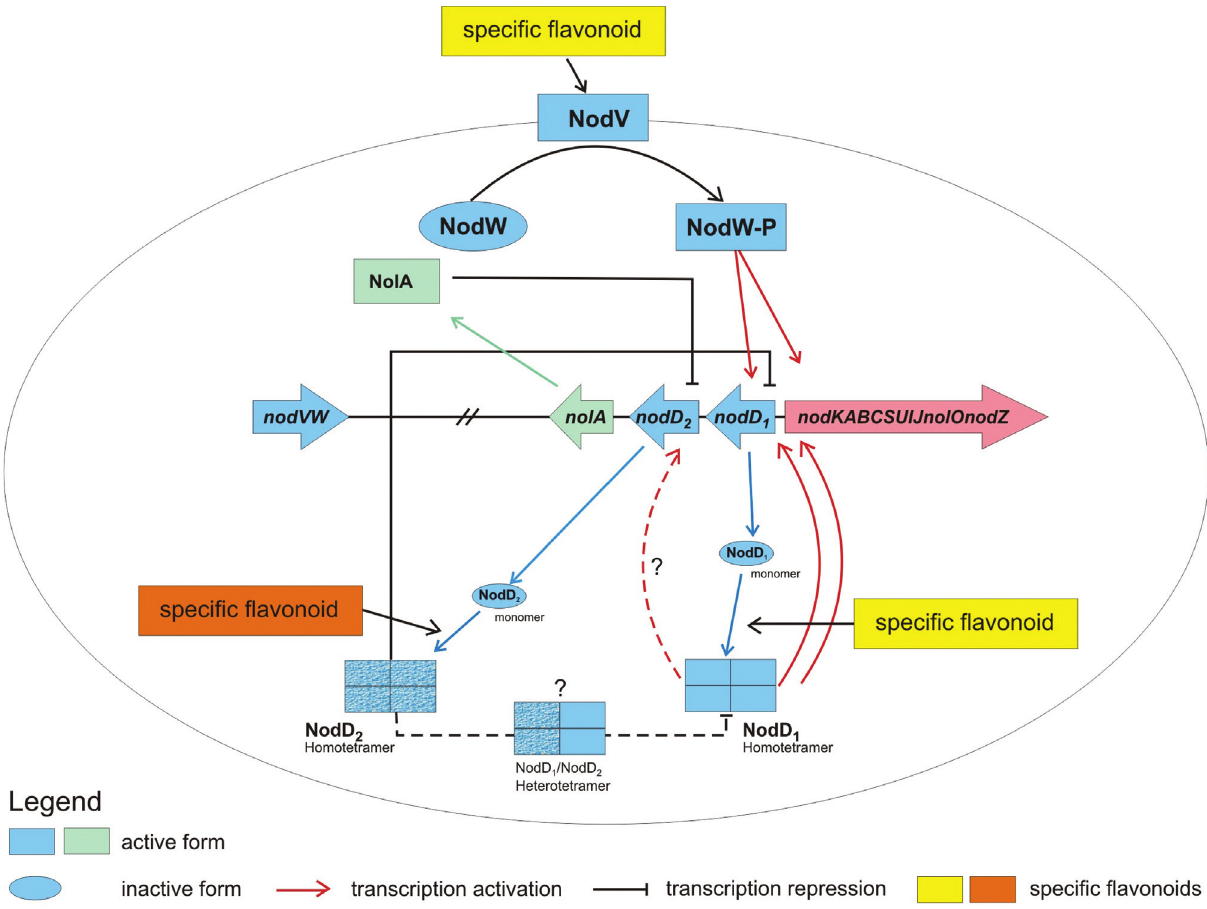
Figure 5 - A model illustrating the modulation of nod gene expression proposed for B. elkanii . Expression of the nod operon containing the structural nod genes is regulated by regulatory nod genes ( nod regulon) in the presence of the respective flavonoid inducer. Transcriptional activation of the nod operon is mediated by NodD 1 and NodVW, resulting in the biosynthesis of lipochitooligosaccharides. Negative regulation of the nod operon is due to the action of NodD 2 and indirectly by NolA. Based on Loh and Stacey